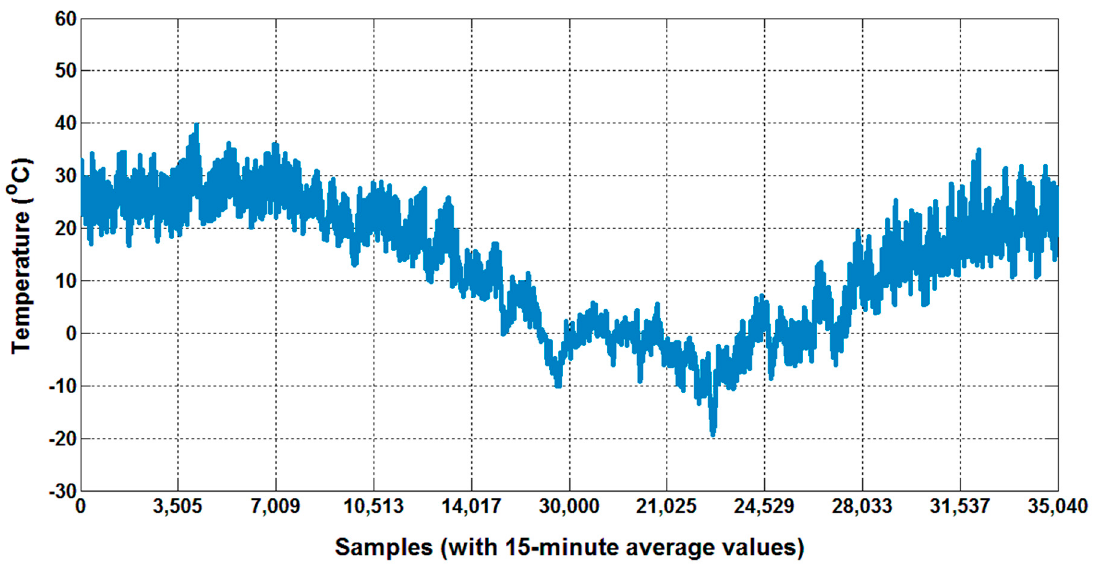
Figure 5. A one-year (1 May 2014–30 April 2015) WRF temperature forecast, with 15-min interval. Similarly, the 15-min average air humidity forecast by the WRF model for one year is given in Figure 6. Processes 2019 , 7 , x FOR PEER REVIEW 11 of 26 Figure 6.